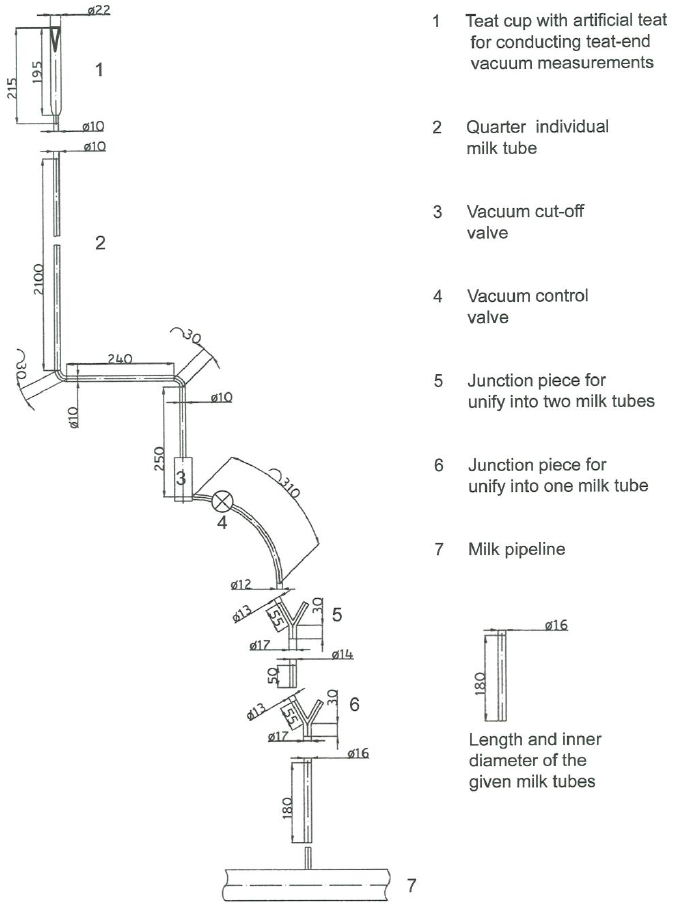
Figure 1. Test set-up with Multilactor ® (MULTI), vacuum control valve (VCV) and the artificial teat